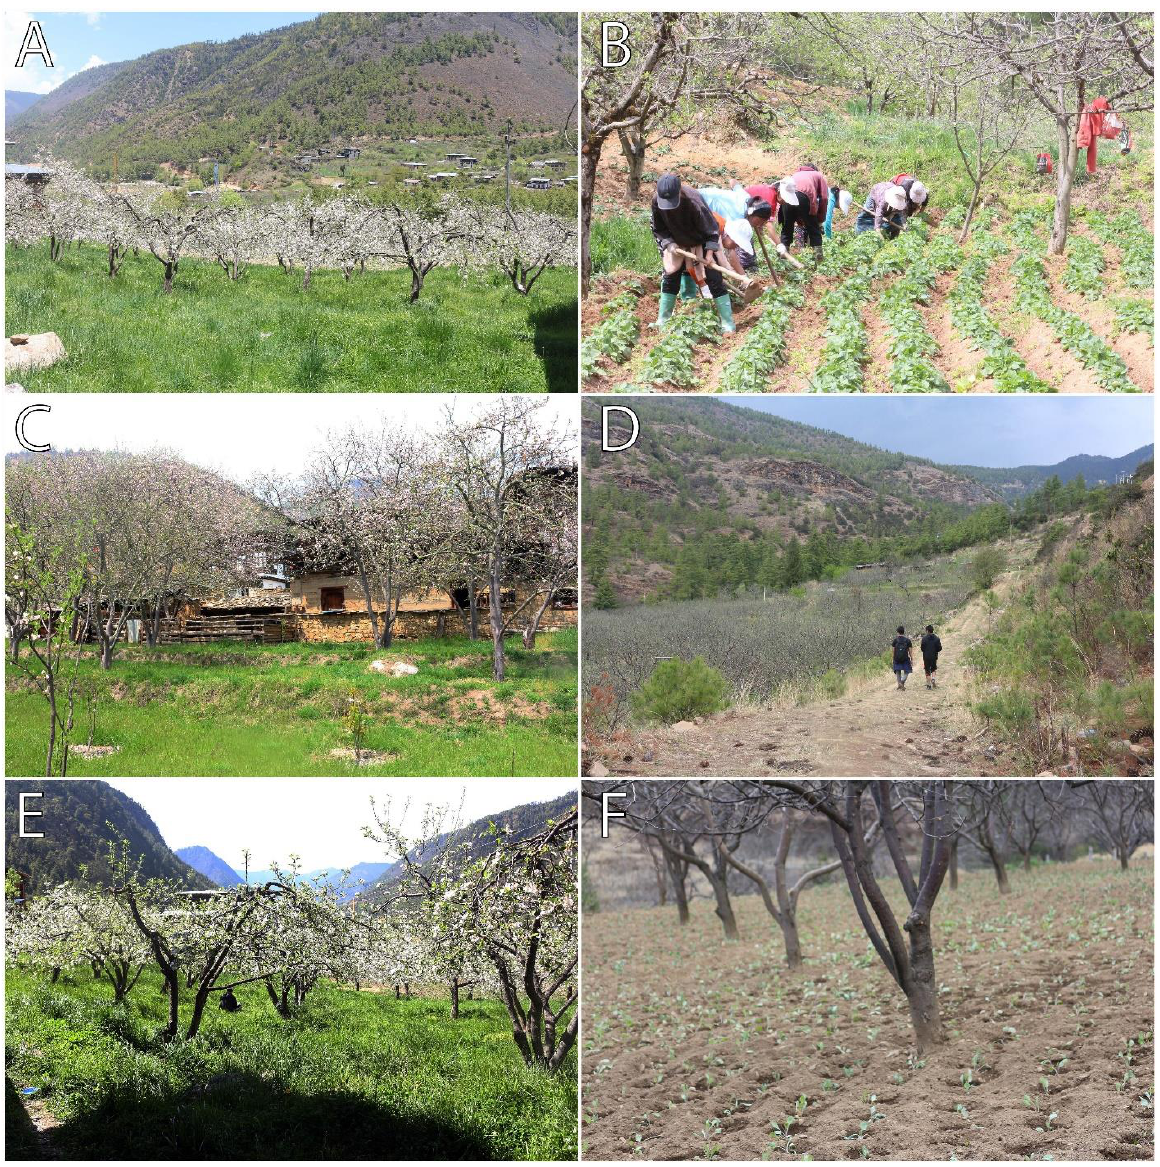
Figure 2. Overview of the diversity and management of a selection of the apple orchards sampled. In general, agricultural areas in Bhutan are found in high-quality landscapes and are much smaller and managed less intensively that in most other parts of the world. (A) Baytsho, Haa, 2690 m (a.s.l). There was an Apis mellifera hive near this orchard which was introduced as part